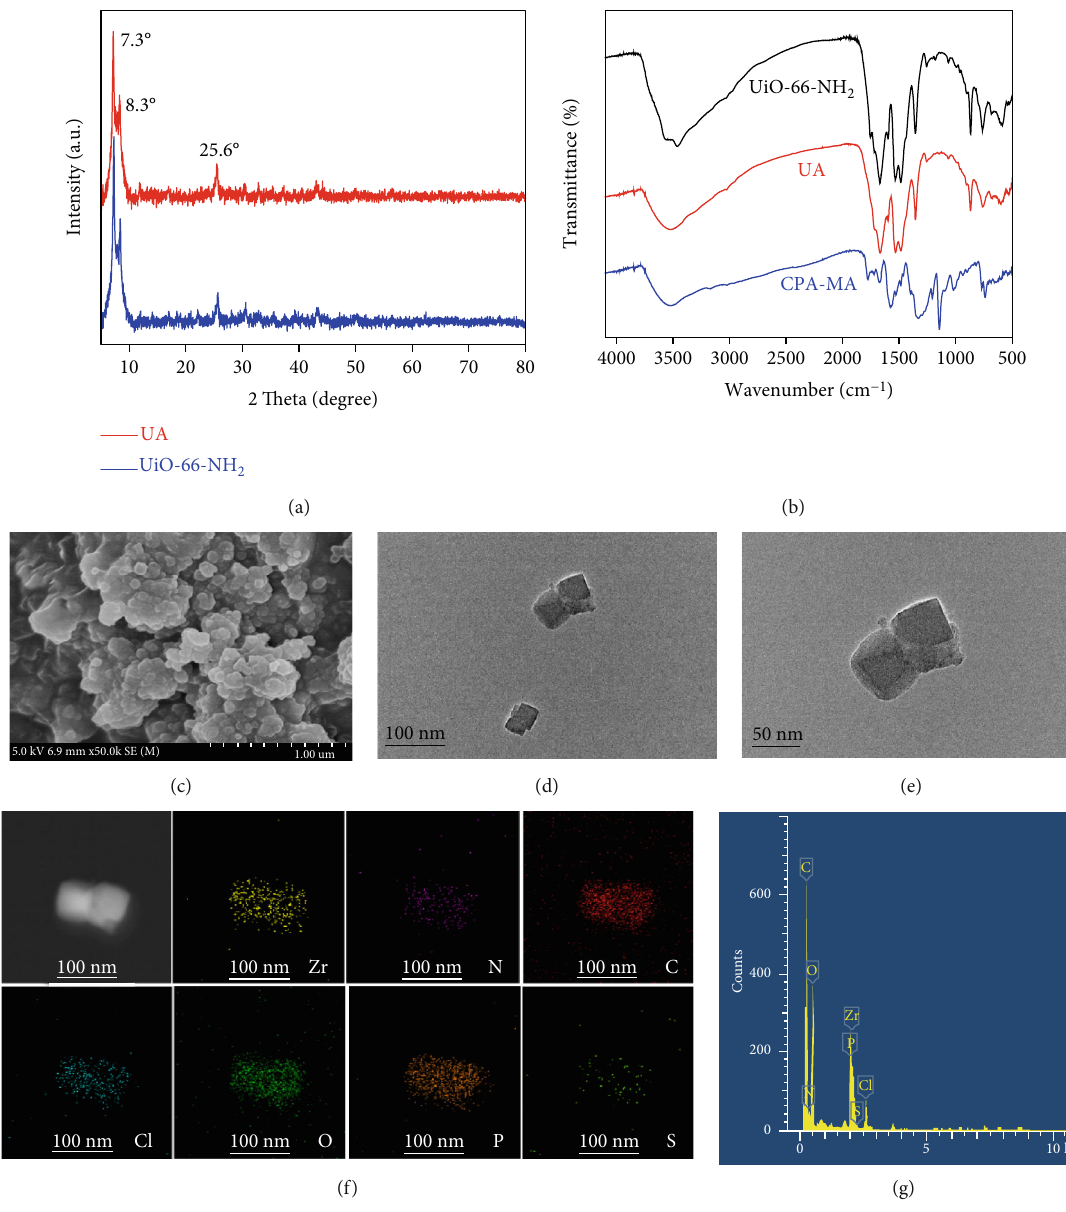
Figure 1: (a) XRD patterns of UiO-66-NH images of UA (c) – (e). Elements mapping analysis and EDX pattern of UA (f,